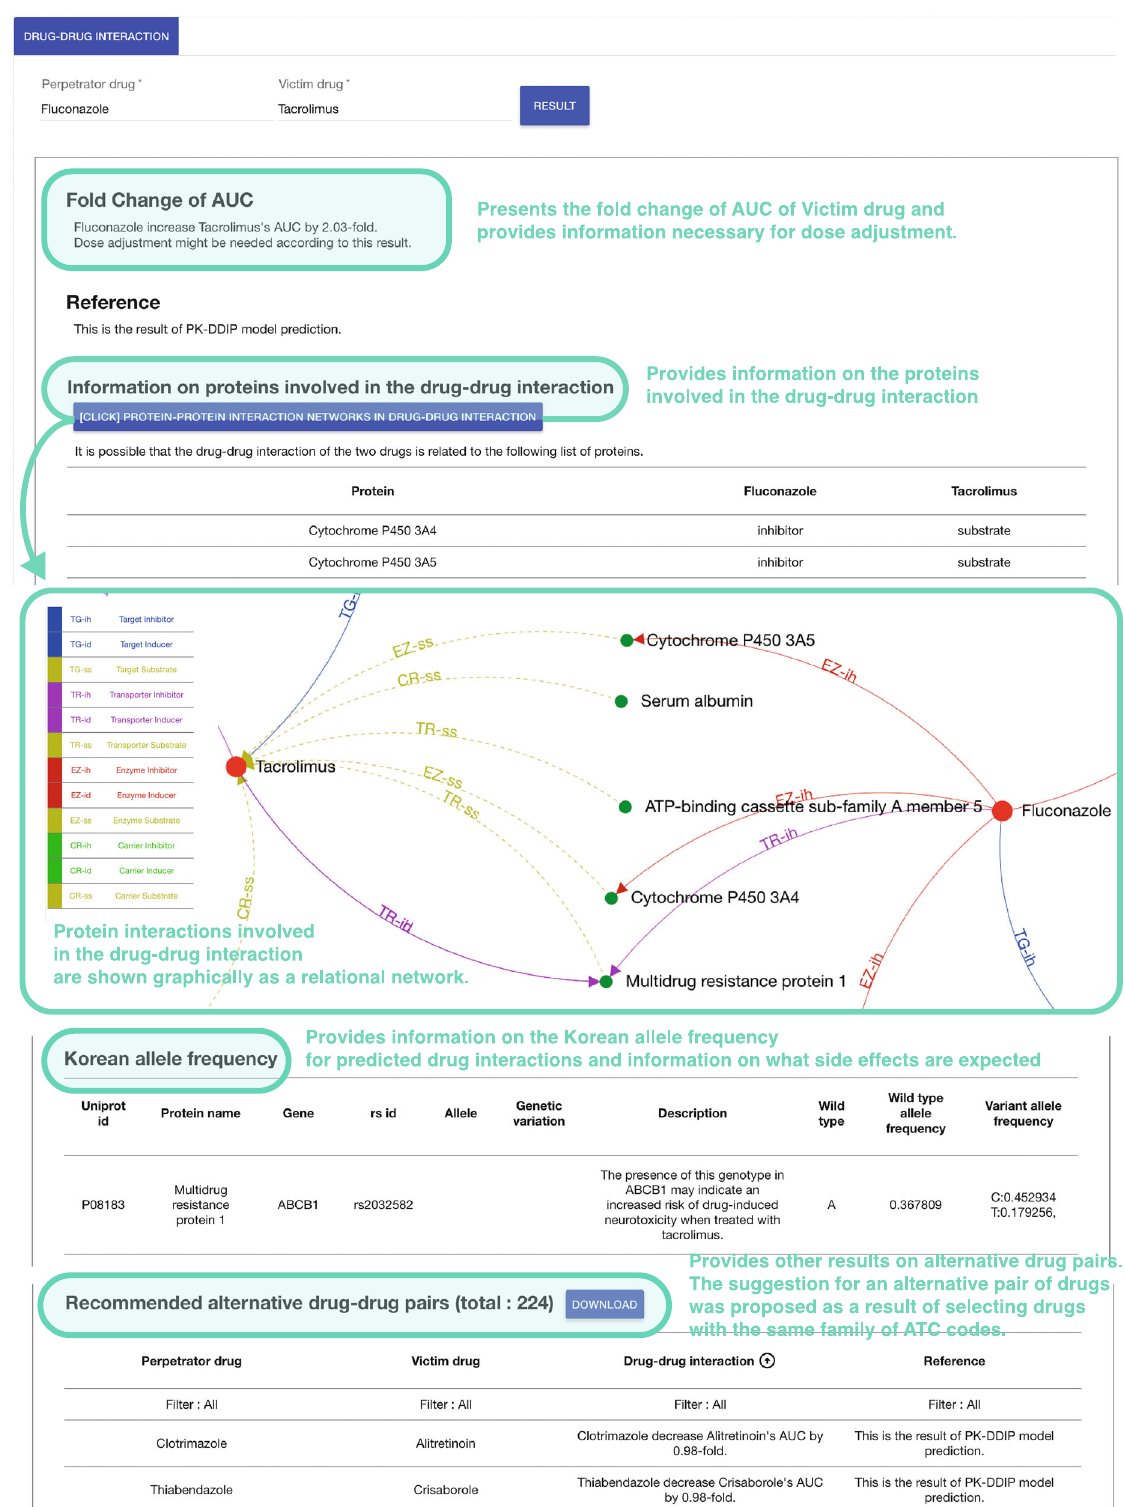
Fig. 4 Standalone application. ATC anatomical therapeutic chemical, AUC area under the time-concentration curve, PK-DDIP pharmacokinetic drug-drug interaction